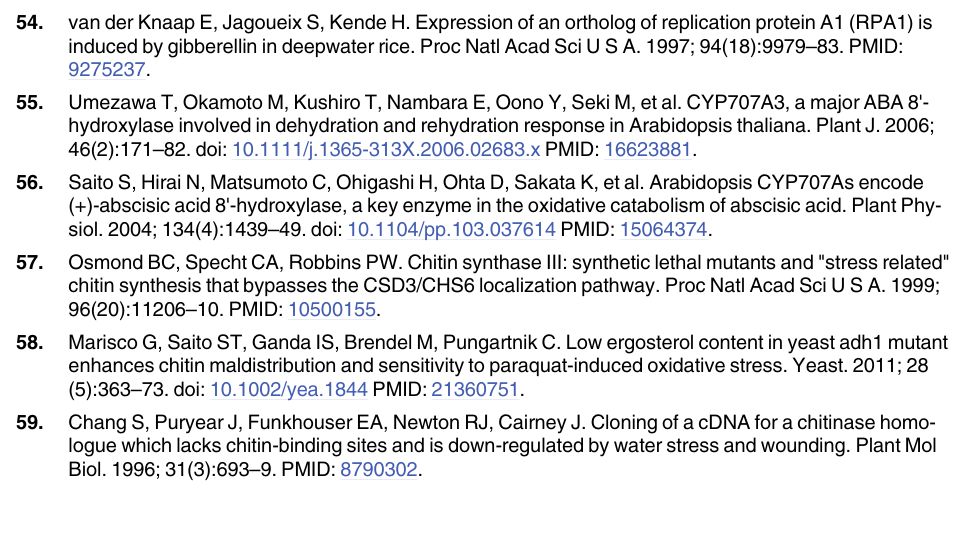
PLOS ONE | DOI:10.1371/journal.pone.0149912 March 2,